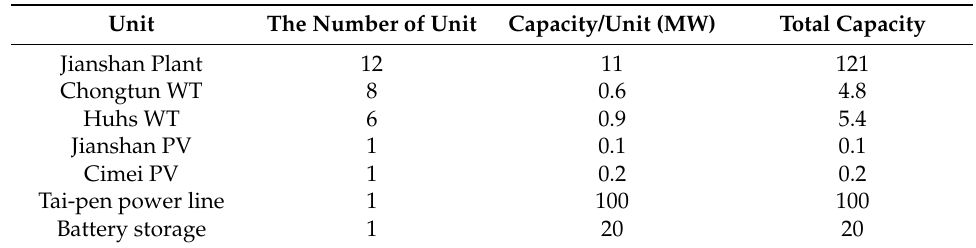
Table 1. Associated data of Penghu